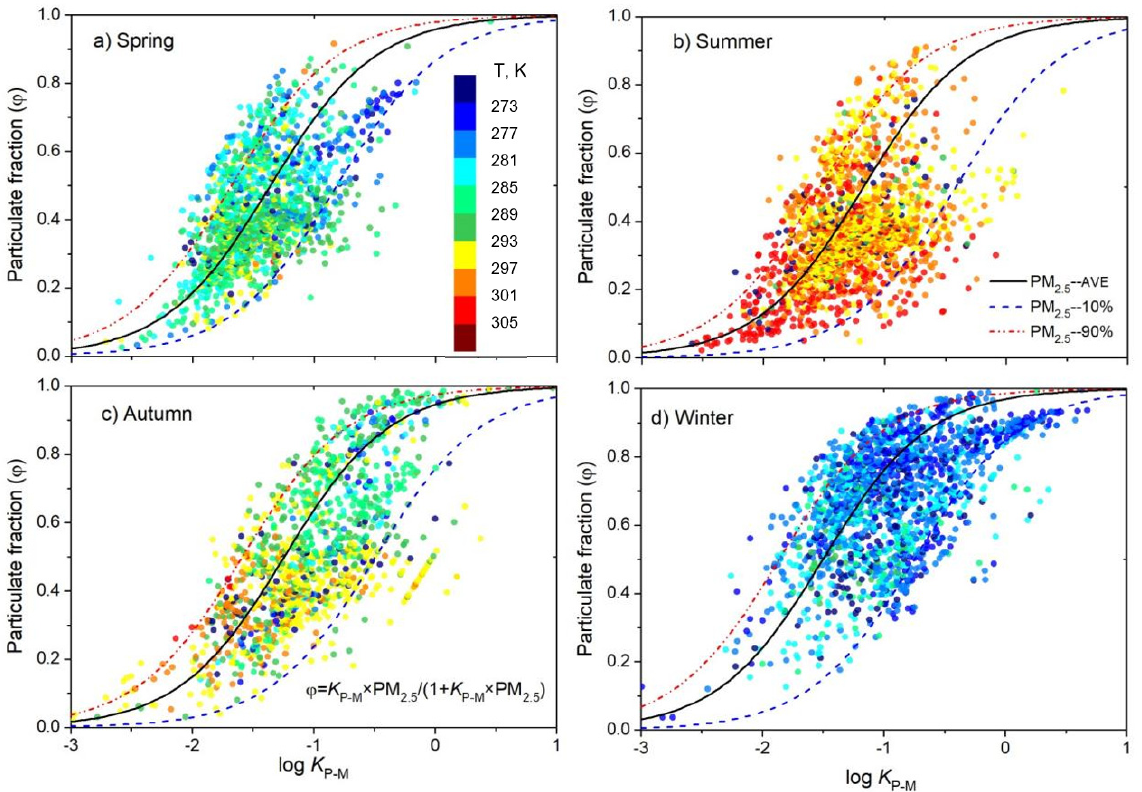
Figure 4. Seasonal relationship between ϕ and log K P-M under different temperature and PM 2.5 concentrations.